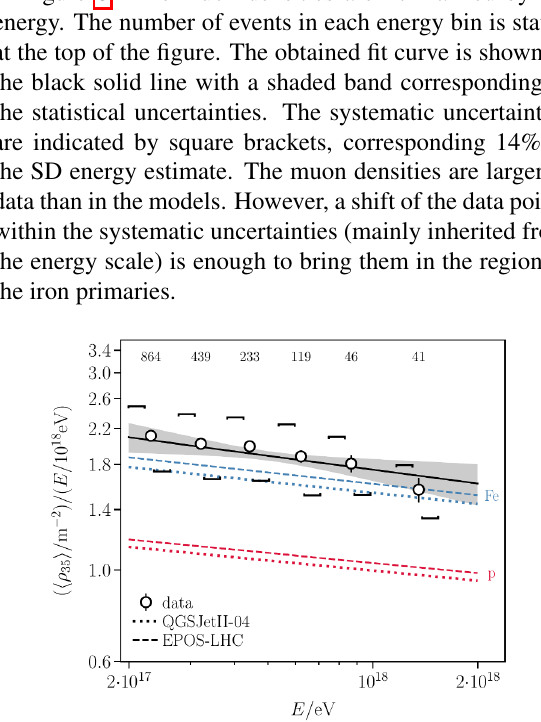
Figure 8. Energy-normalized muon densities compared to the expectations from simulations using QGSJetII-04 (dotted) and EPOS-LHC